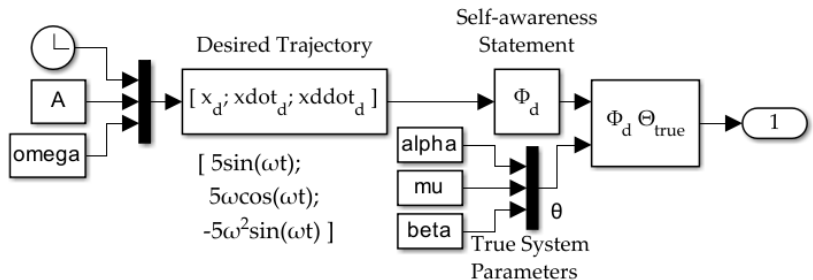
Figure 5. The forcing function block, 𝐹(𝑡) , with feedforward only.